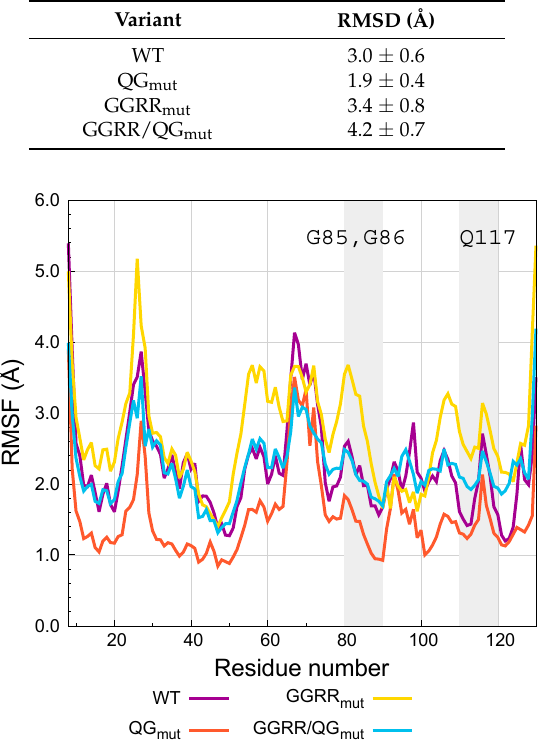
Table 1. Root mean square deviation (RMSD) of the C α carbons of WT angiogenin and the mutants QG mut , GGRR mut , GGRR/QG mut complexed with RNH1 measured from REST2 simulations.